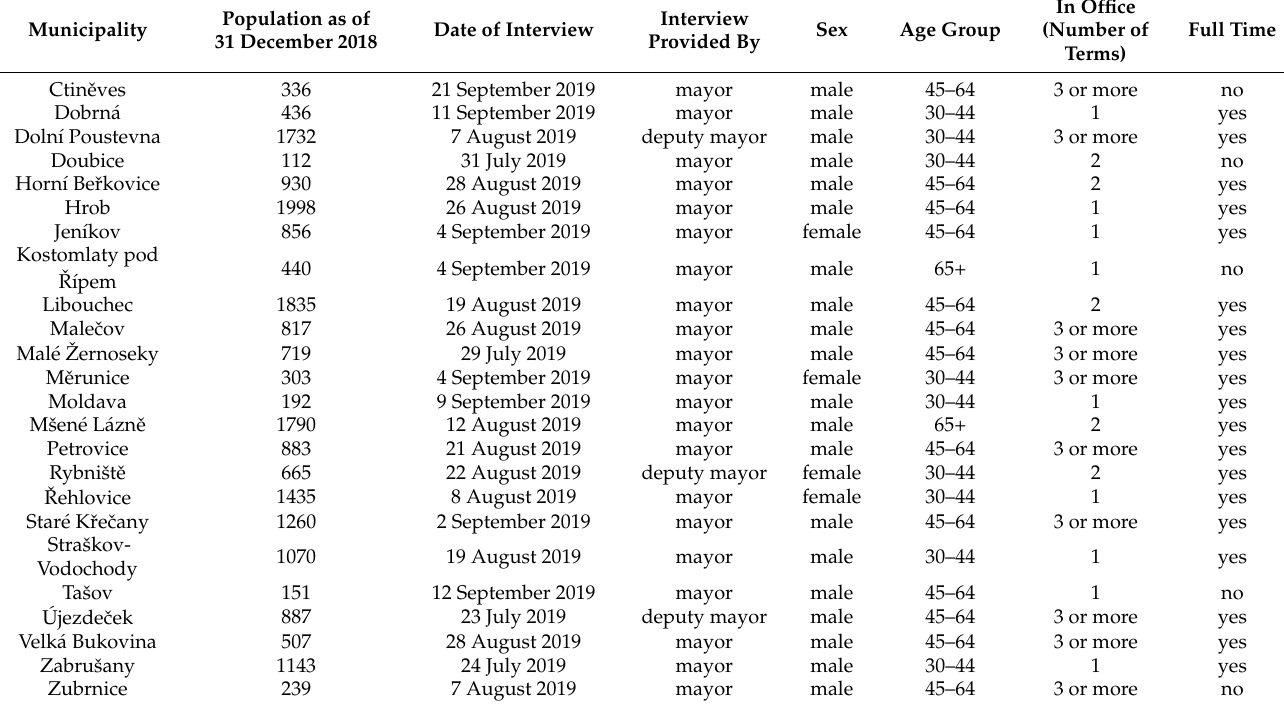
Table 1. Overview of the